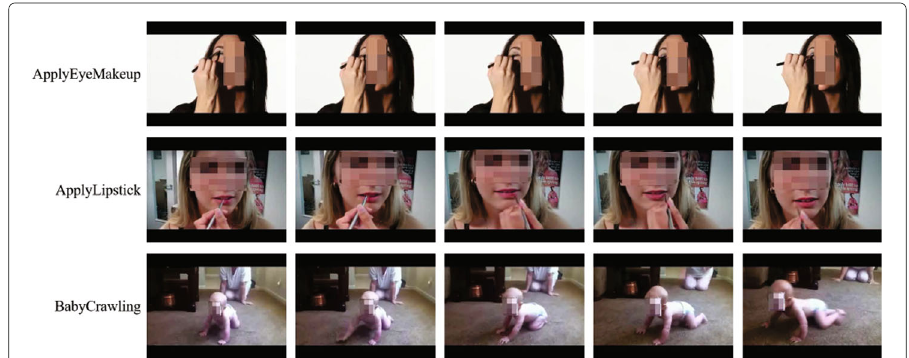
Fig. 6 Examples of the videos selected for qualitative